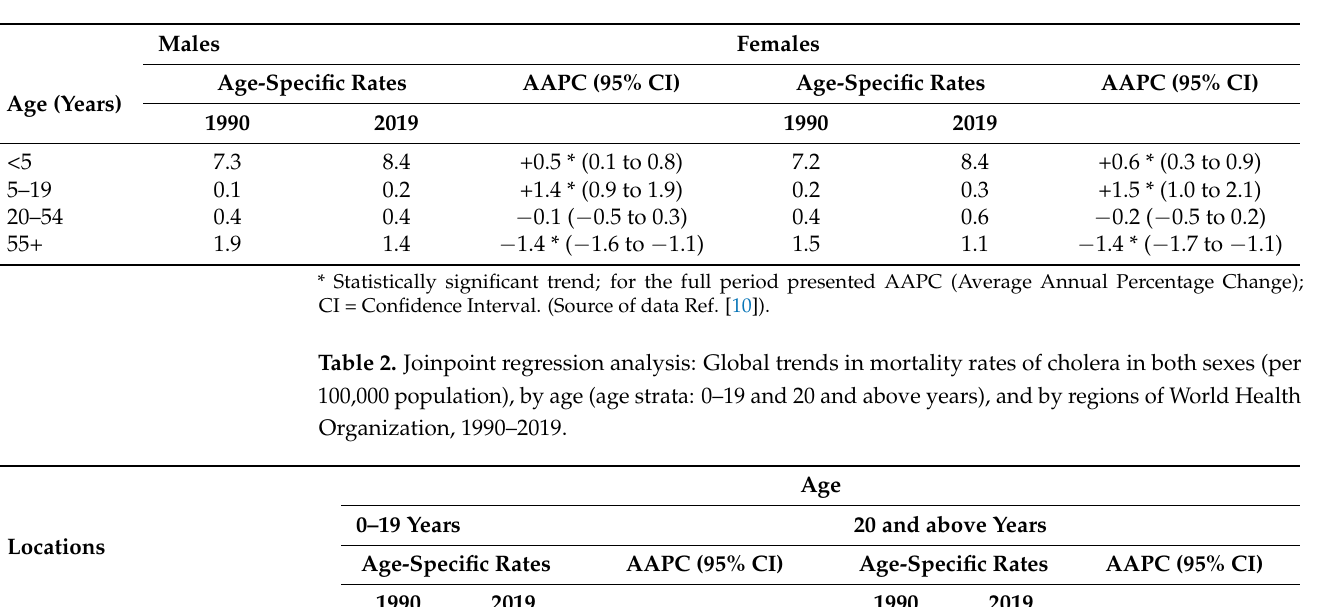
Table 1. Joinpoint regression analysis: global trends in age-specific mortality rates of cholera (per 100,000 population), by sex, 1990–2019.